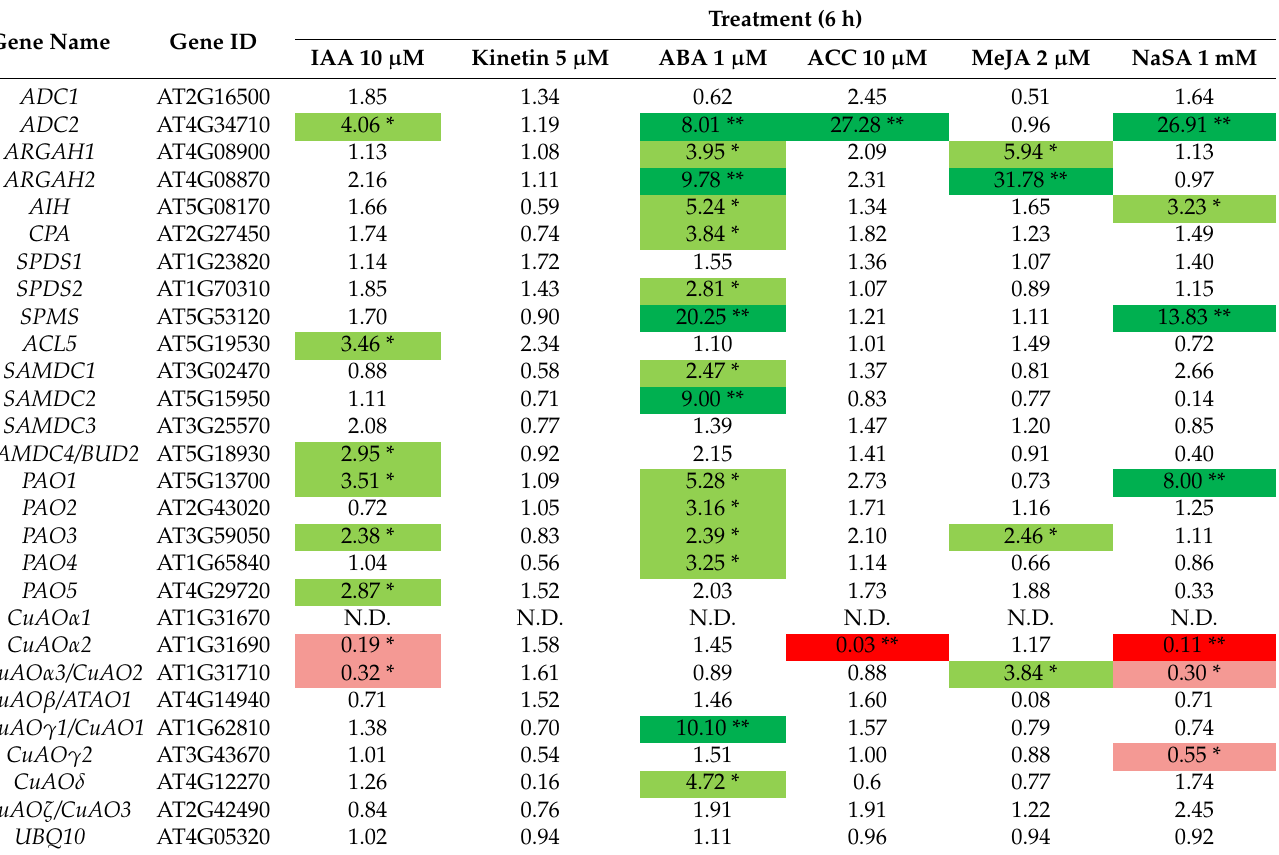
Table 2. Effect of plant hormone treatment on polyamine metabolic